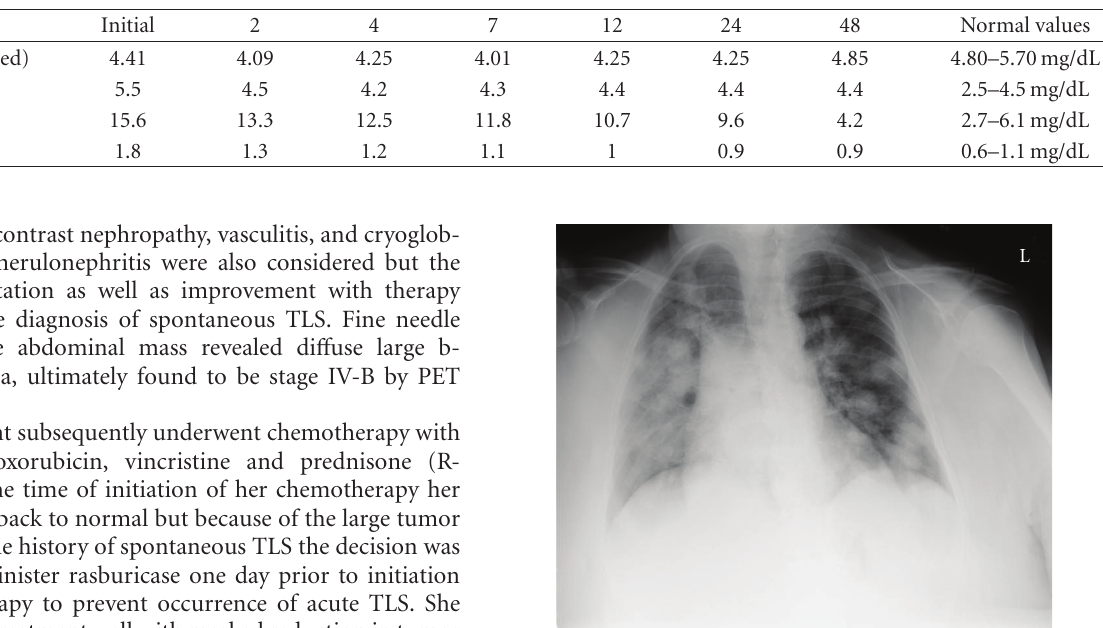
Table 1: Essential laboratory values during the first 48 hours of treatment.